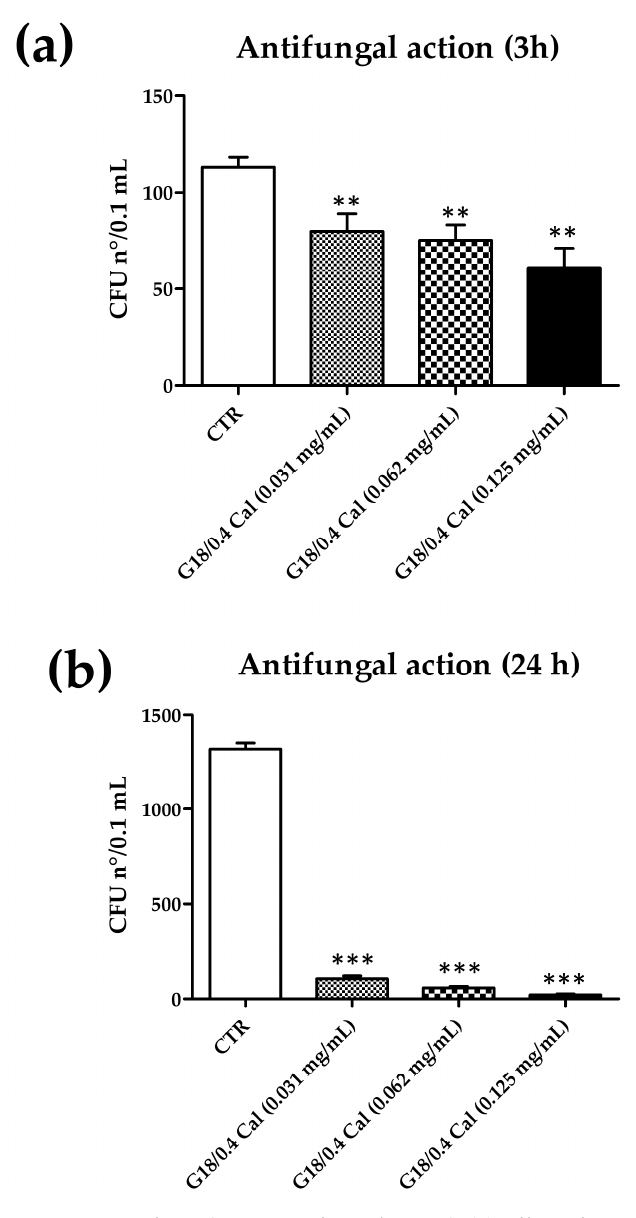
Figure 7. Antifungal activity of G18/0.4 Cal. ( a ) Effect after 3 h of contact. ( b ) Effect after 24 h of contact. CTR, control yeasts receiving G18/0.4 gel without Cal; CFU, colony forming units. Results are expressed as mean value of CFUs ± s.d. obtained from triplicate samples from two independent experiments; ** p value < 0.01; *** p values < 0.001.